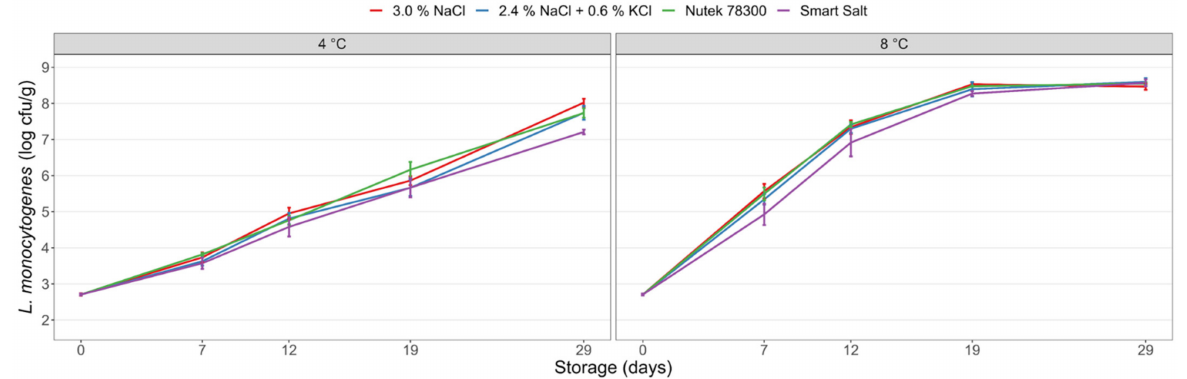
Figure 2. Growth of L. monocytogenes in CS salmon produced with NaCl (control) and different sodium-reduced mineral salts (Treatments no. 1-4; Table 1). The salmon fillets were treated with the different salts to a level of 3% ( w / w ). After smoking, the CS salmon was inoculated with L. monocytogenes at day 0 and stored under vacuum at 4 ◦ C and 8 ◦ C for 29 days. Mean values of two experiments (four to eight measurements per data point) and standard error of the mean are